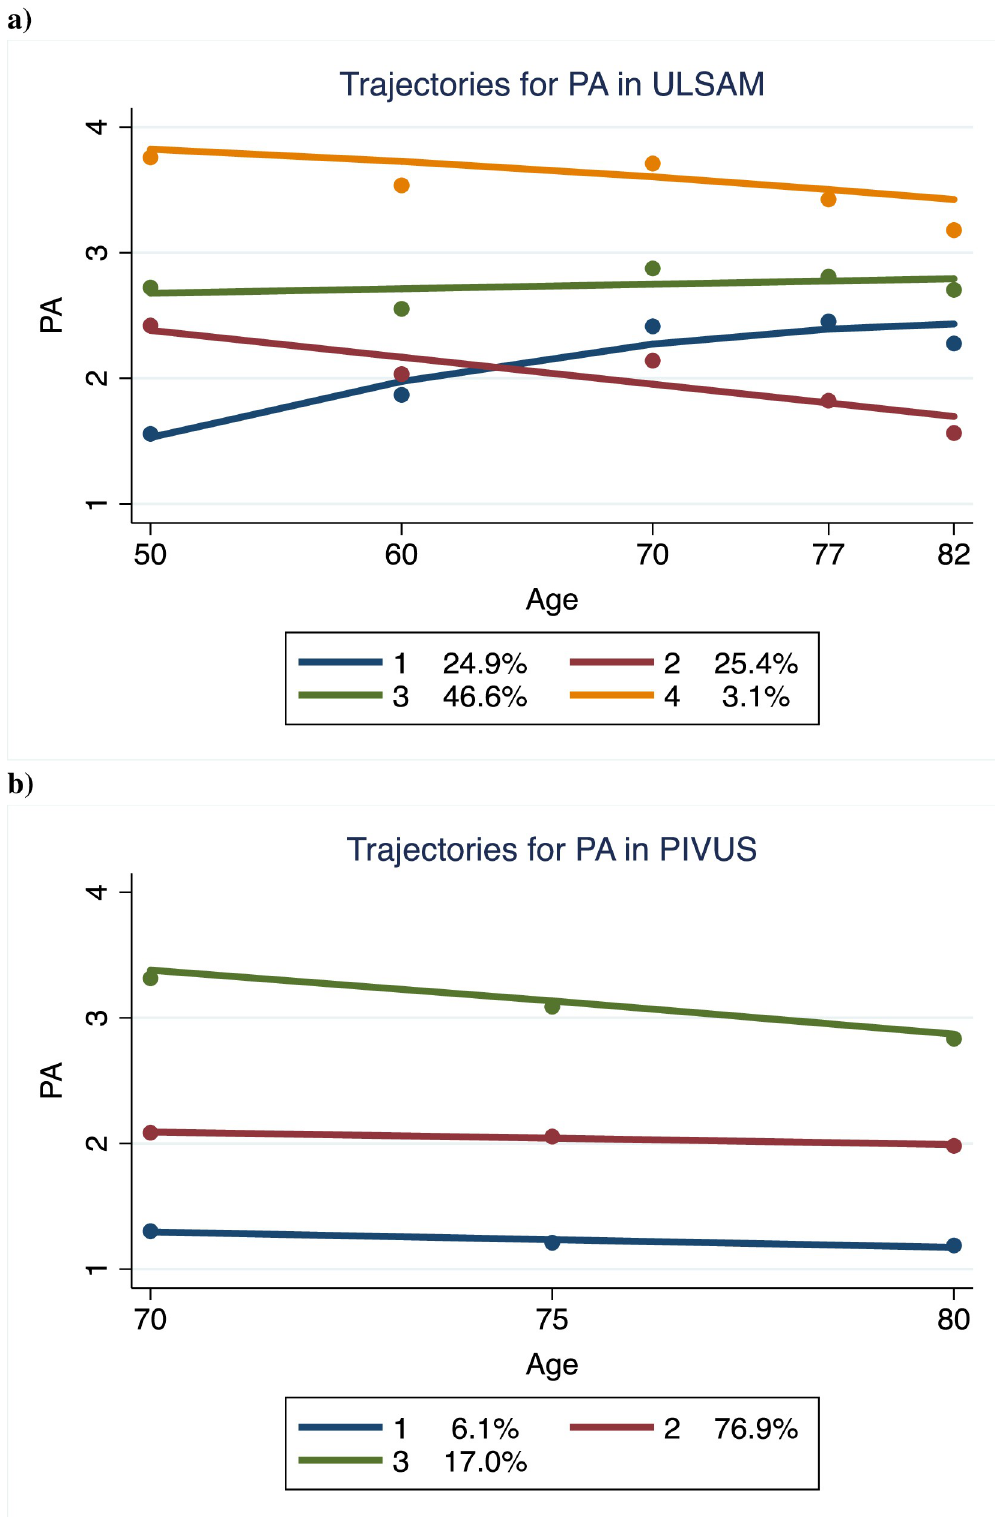
Fig 3. Trajectories for physical activity (PA) in a) ULSAM and b) PIVUS. The proportion of subjects in each trajectory is given.